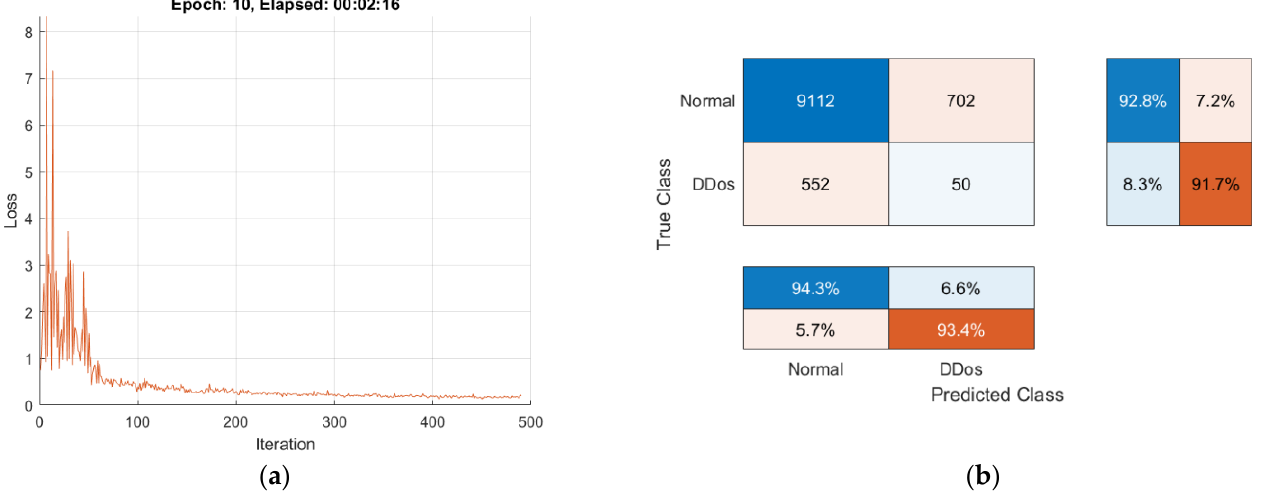
Figure 15. Training progress and performance of the FL method: ( a ) loss evaluation of Local Model2; ( b ) confusion matrix of Local Model2.